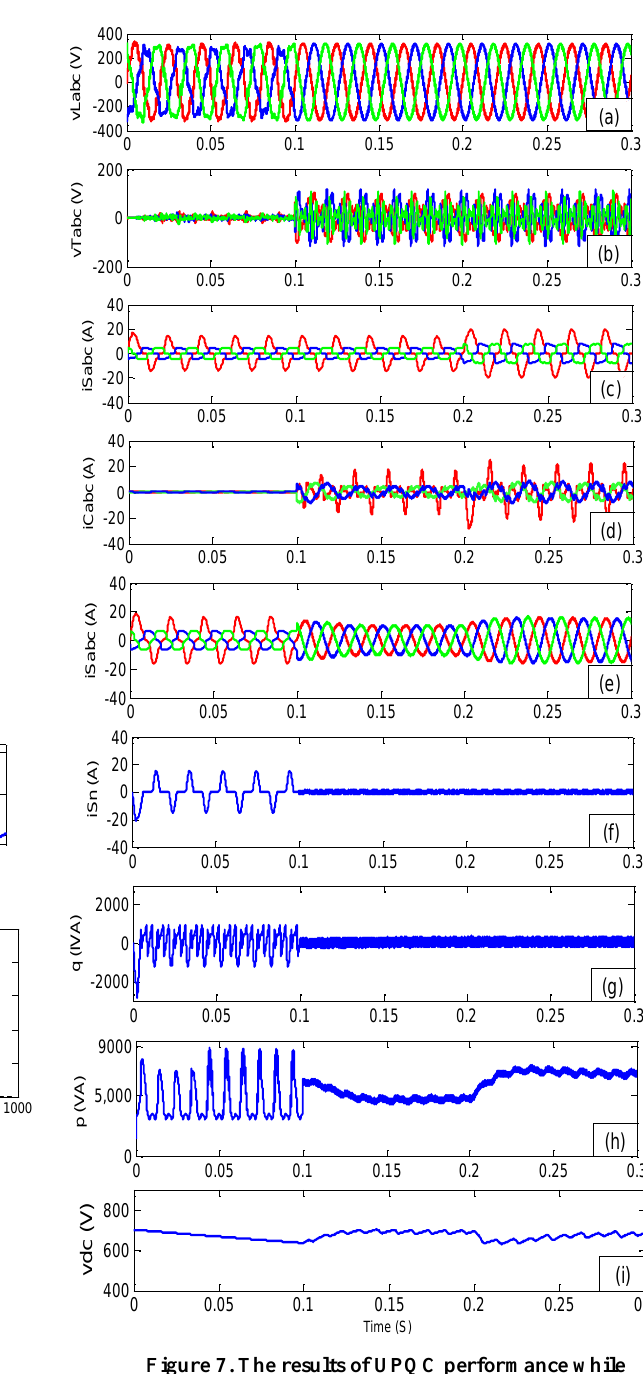
Figure 7. The results of UPQC performance while operating. (a) load voltages, (b) voltages injected by the series transformers (c) load currents (d) source currents (e) the injected compensating currents (f) source neutral current (g) instantaneous reactive power (h) instantaneous active power (i) dc link